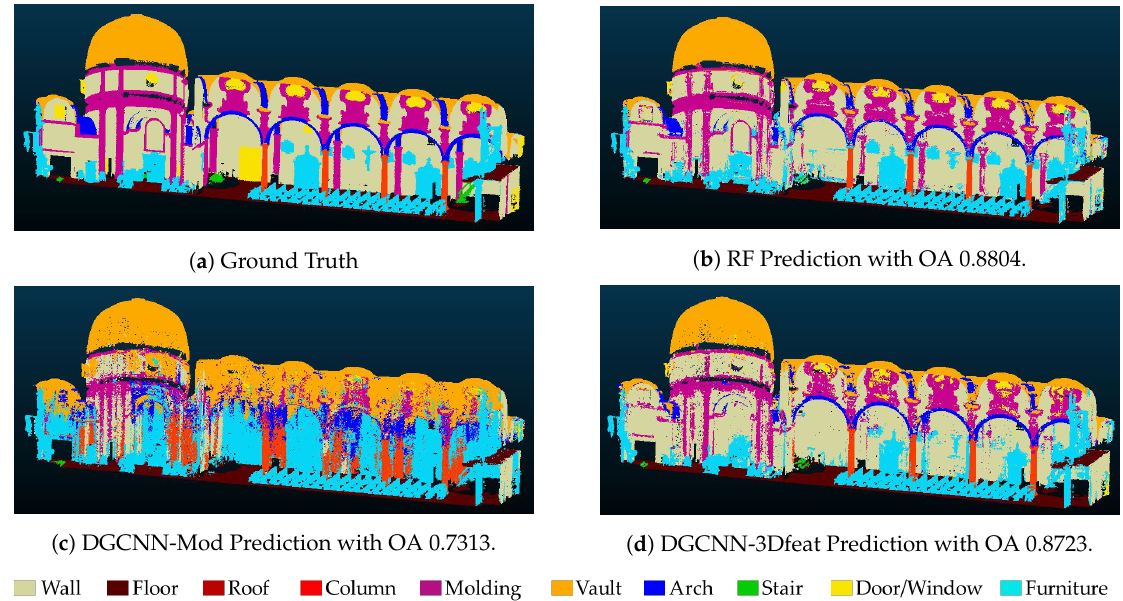
Figure 4. Ground Truth and predicted point clouds, by using best approaches on Trompone’s Test side.